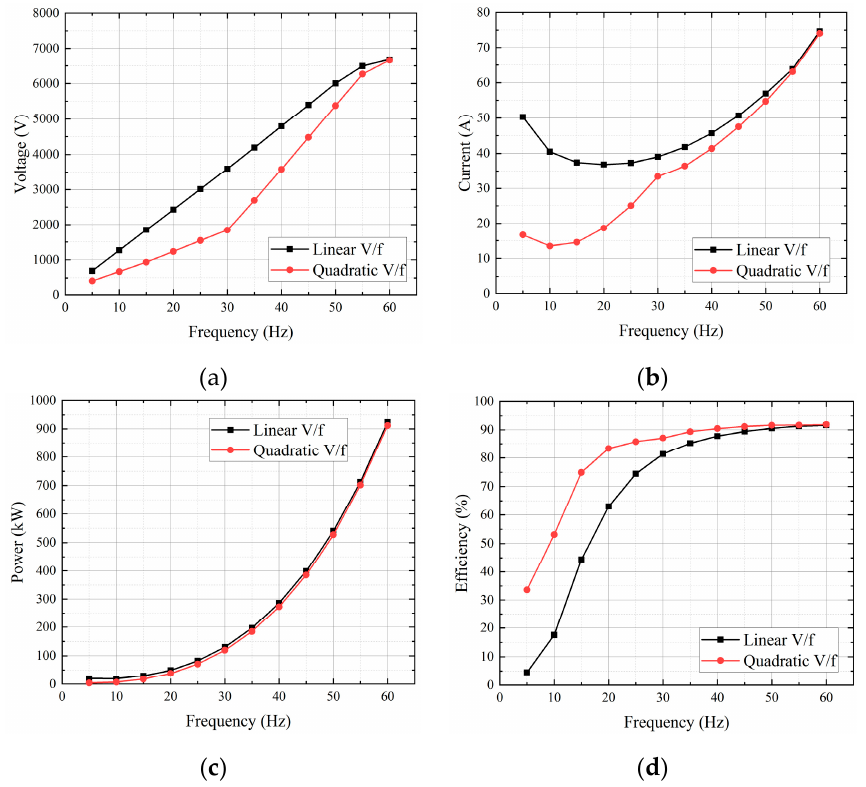
Figure 5. Performance curves measured at the input terminals of induction motor according to linear and quadratic V/f controls. ( a ) Line to line voltages curves; ( b ) phase current curves; ( c ) power curves; ( d ) efficiency curves of the induction motor.